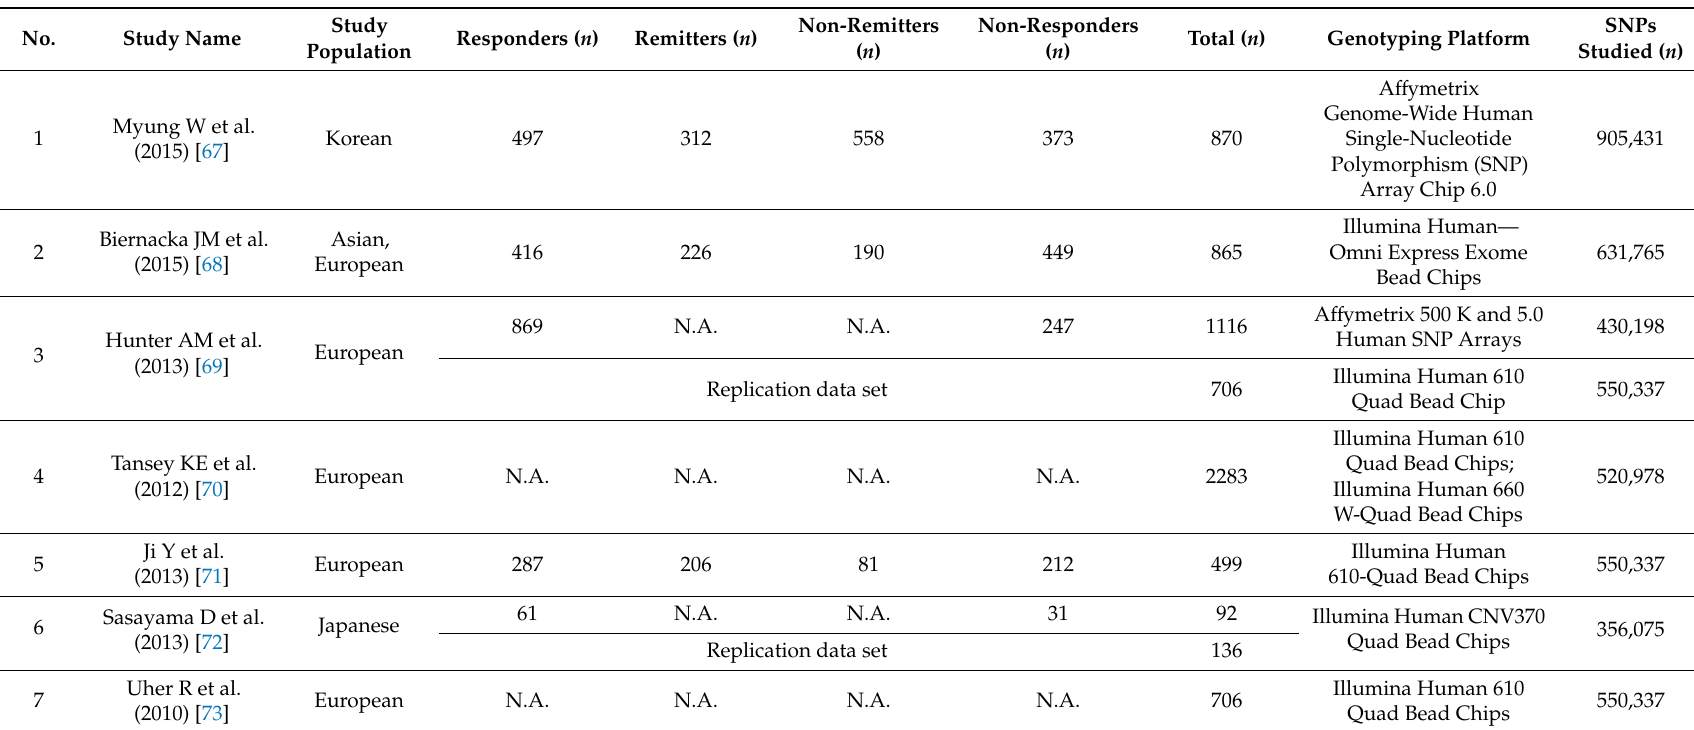
Table 2. Characteristics of included genome-wide association studies concerning SSRI response in major depression